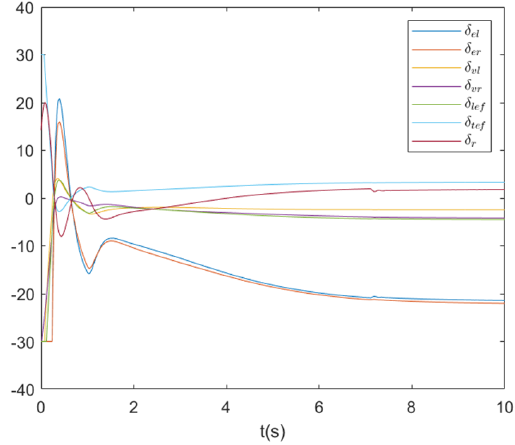
Figure 8. Actuator actions of Fighter 2.